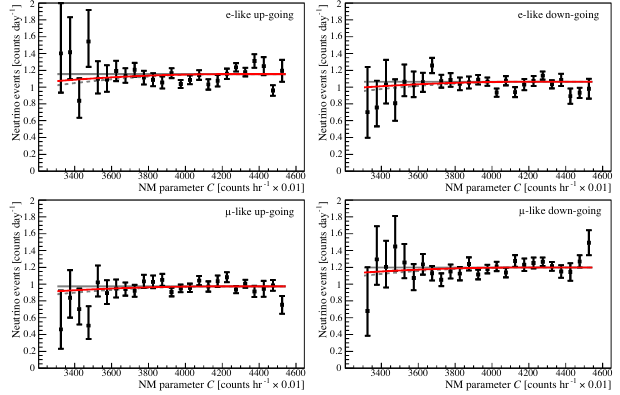
Figure 9. The test for a solar modulation correlation using the Super-K data (points). The solar correlation hypotheses are shown for no correlation ( α = 0, grey), best fit ( α = 0.62, red), and the default prediction ( α = 1, grey dotted) for each of the four data